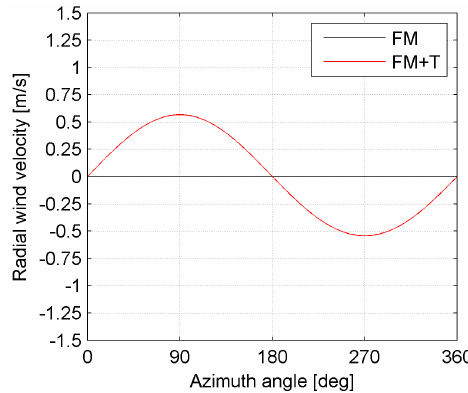
Figure 14. Computed impacting radial wind velocity at 75% of the blade span (see Figure 4 for the sign convention).